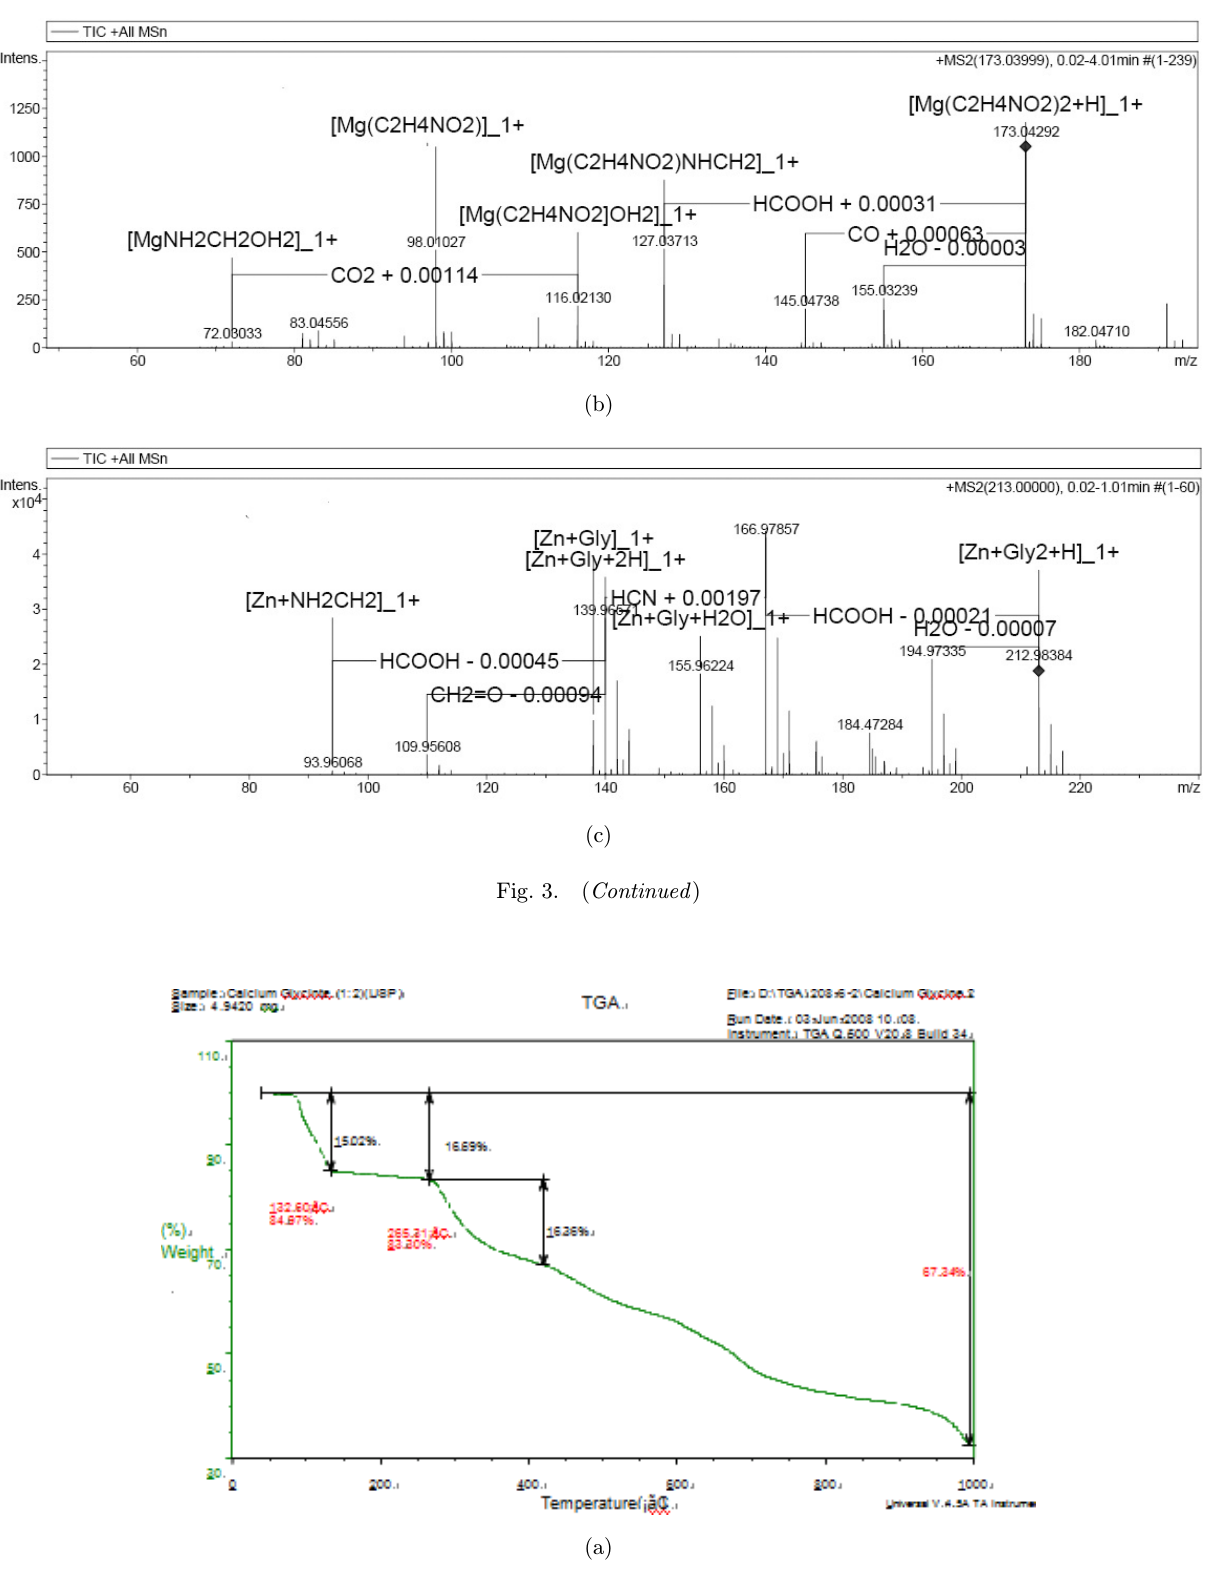
Fig. 4. The GTA of calcium glycinate (a), the DTA of calcium glycinate (b), the GTA of magnesium glycinate (c), the DTA of magnesium glycinate (d), the GTA of zinc glycinate (e), the DTA of zinc glycinate (f).